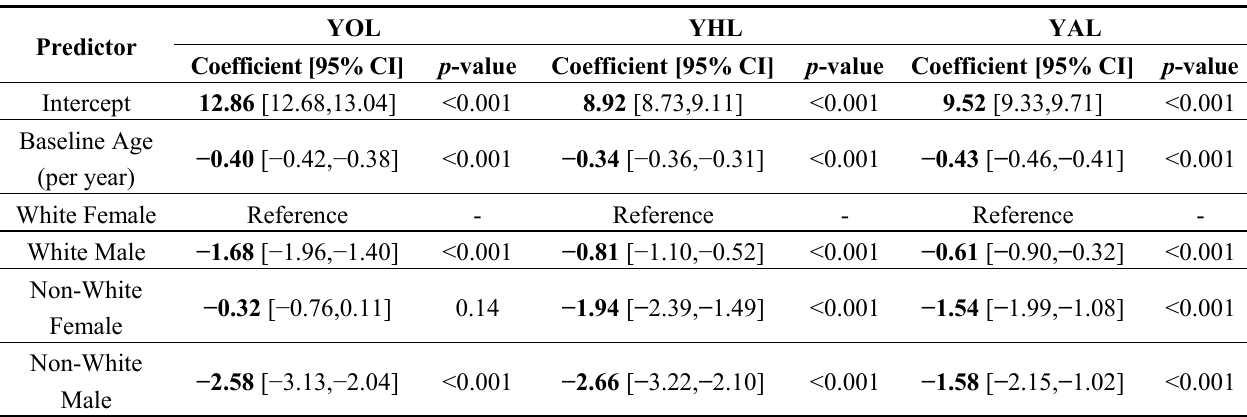
Figure 2. Cumulative years of able life (YAL) during 18 years of follow-up by age, sex, and race groups. Table 2 summarizes the regression parameters from models using YOL, YHL, and YAL as outcomes, adjusted for linear age. At the mean age of 73 years, white women had significantly greater YOL, YHL, and YAL than all the other groups, with the exception of YOL, where non-white women and white women did not differ significantly. Centered at a mean age of 73, a white female participant could expect 12.9 years of life, 8.9 of healthy life and 9.5 of able life, while a non-white female had 12.6 years of life, 7.0 years of healthy life, and 8.0 years of able life. A white male could expect 11.2 years of life, 8.1 years of healthy life, and 8.9 years of able life, and a non-white male 10.3 years of life, 6.2 years of healthy life, and 7.9 years of able life. For all three measures, white men had significantly better outcomes than non-white men. White men had significantly better YHL and YAL outcomes than non-white women, but non-white women had higher YOL than white men. Table 2. Linear regressions of age and sex/race groups on YAL, YOL, or YHL for 5888 CHS participants. Coefficients represent the difference in number of years of healthy life, able life, or total life during 18 years of